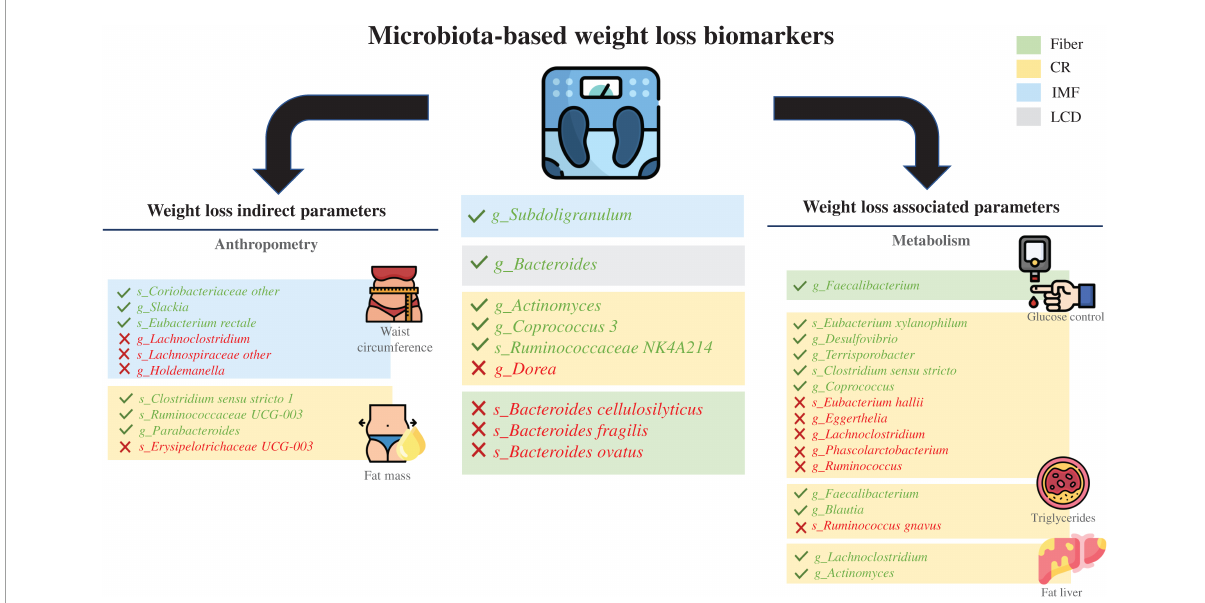
FIGURE1 Schematic results of all the clinical trials reviewed. Taxa in green indicate a positive predictive manner, and taxa in red indicate a negative predictive manner. Dietary interventions and their influence on obesity-related metabolic parameters with a focus on weight loss as well as the correlated gut microbiota taxa at the genus or species level. CR, caloric restriction; IF, intermittent fasting; LCD, low-carbohydrate